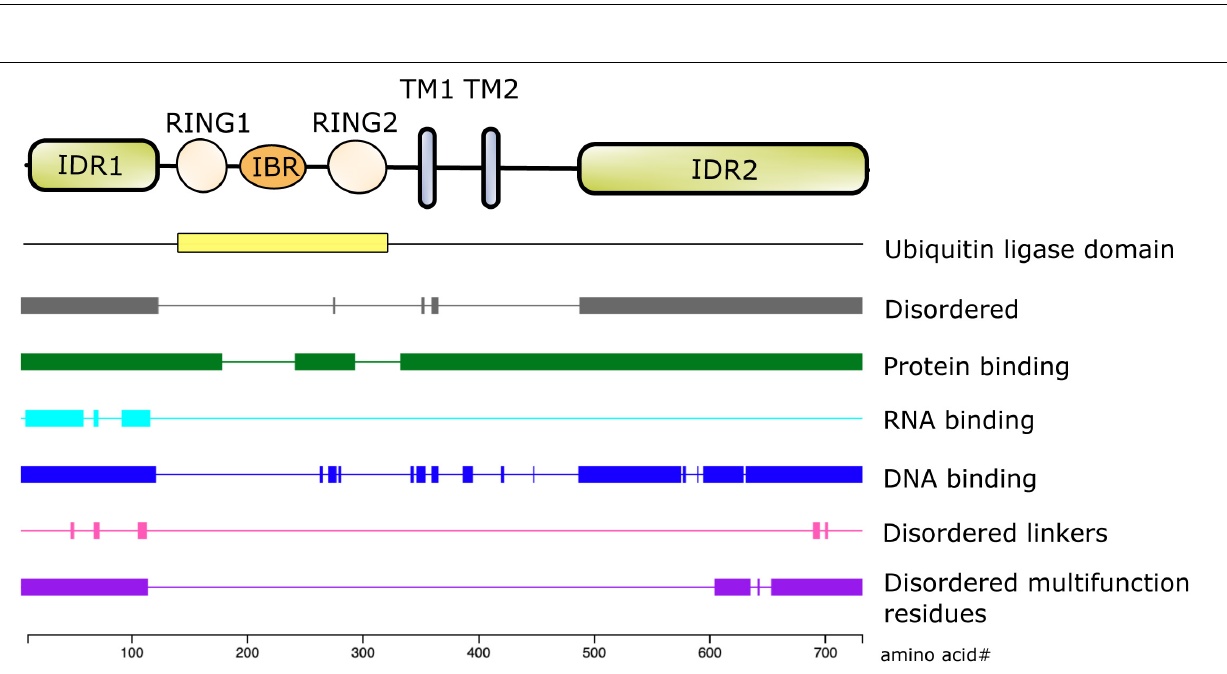
Frontiers in Physiology |